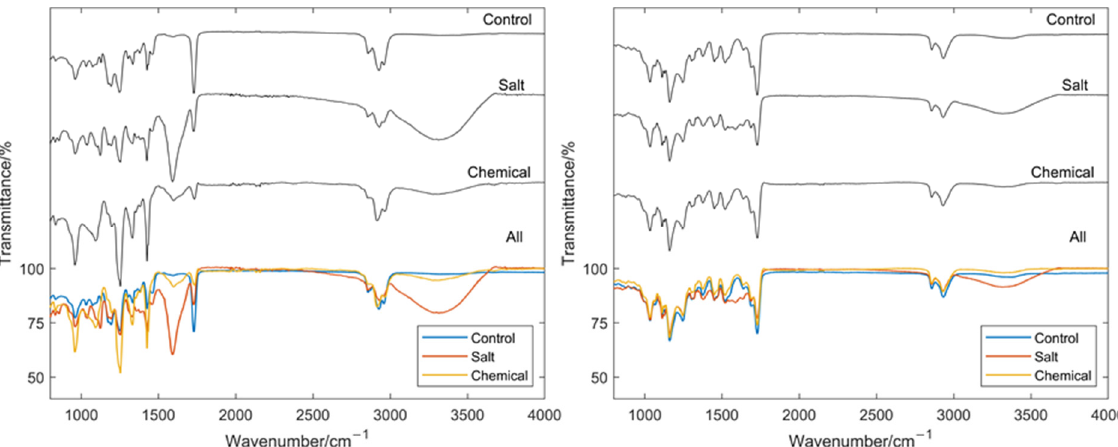
Figure 18. Resulting FTIR spectra for an example PVC sample ( left ) and example PU sample ( right ).